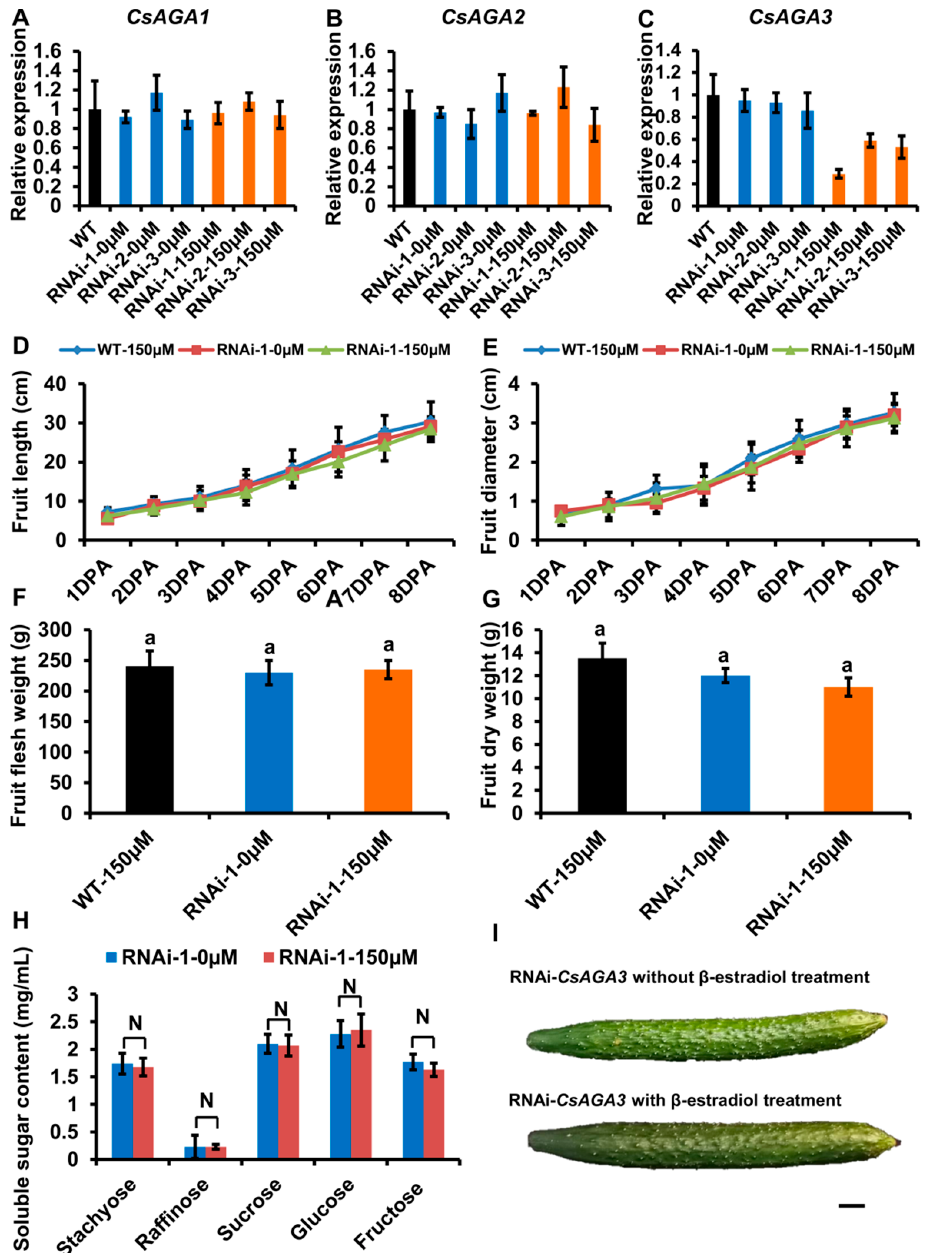
Figure 6. CsAGA3 did not regulated stachyose and raffinose hydrolysis. ( A – C ) qRT-PCR analysis of the expression of CsAGA1 ( A ), CsAGA2 ( B ) and CsAGA3 ( C ) in RNAi- CsAGA3 plants with or without β -estradiol treatment. The expression of CsAGA3 was down regulated in RNAi- CsAGA3 plants treated with β -estradiol, but not in RNAi- CsAGA3 plants without β -estradiol treatment ( B ). The expression of CsAGA1 ( A ) and CsAGA2 ( B ) were not regulated in RNAi- CsAGA3 plants treated with 150 μ M β -estradiol. Three lines of RNAi- CsAGA2 were chosen for qRT-PCR analysis. The bars